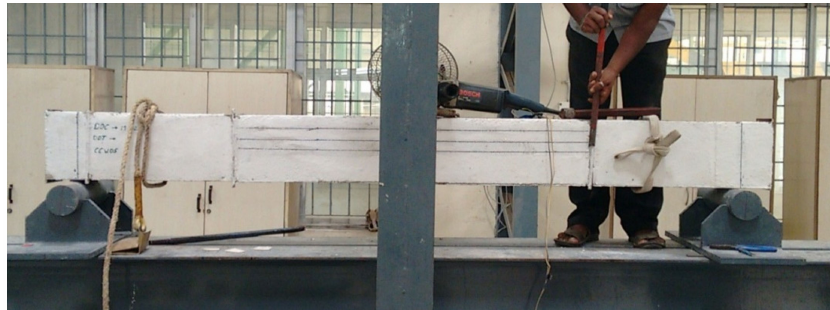
Figure 8. Removal of gauge rod in a SCS element without shear studs.